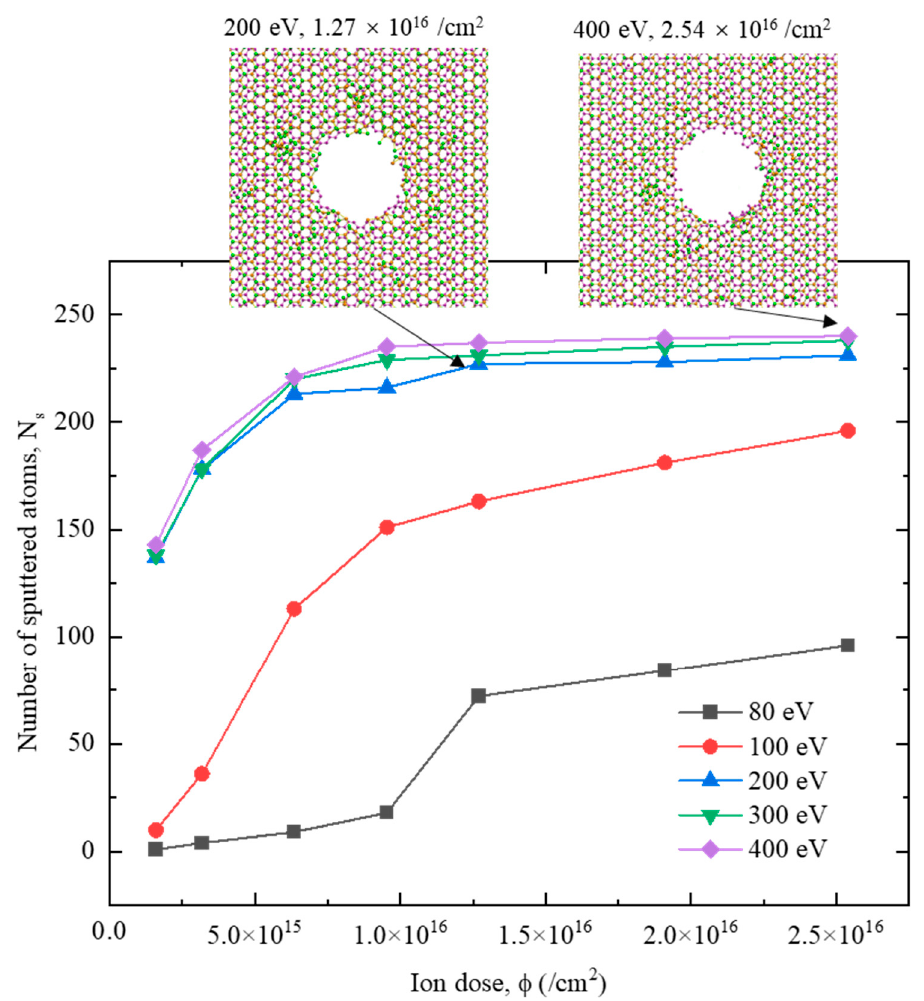
Figure 5. Number of sputtered atoms of the G/M heterostructure under ion irradiation with different ion energies and ion doses. The inserted figures show the configurations of 200 eV, 1.27 × 10 16 /cm 2 , and 400 eV, 2.54 × 10 16 /cm 2 , respectively.